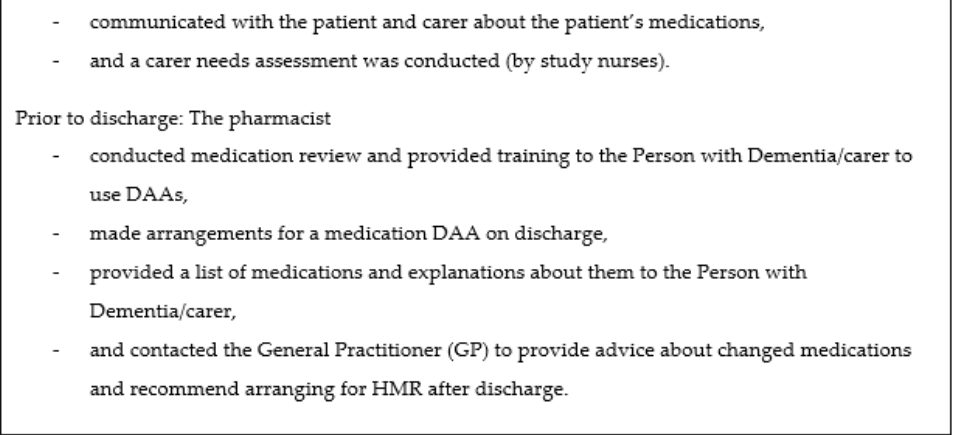
Figure 1. Seven safe medication strategies delivered routinely as a bundle (intervention).